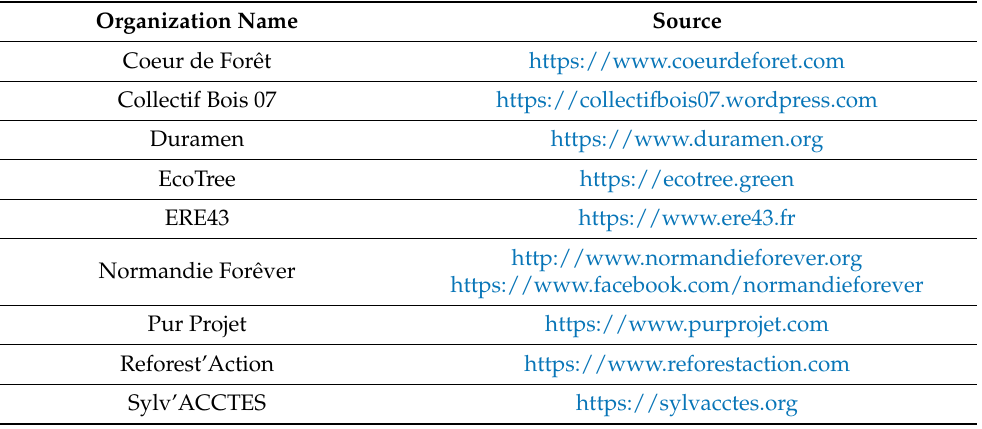
Table A1. List of identified carbon projects. All websites were accessed online on September